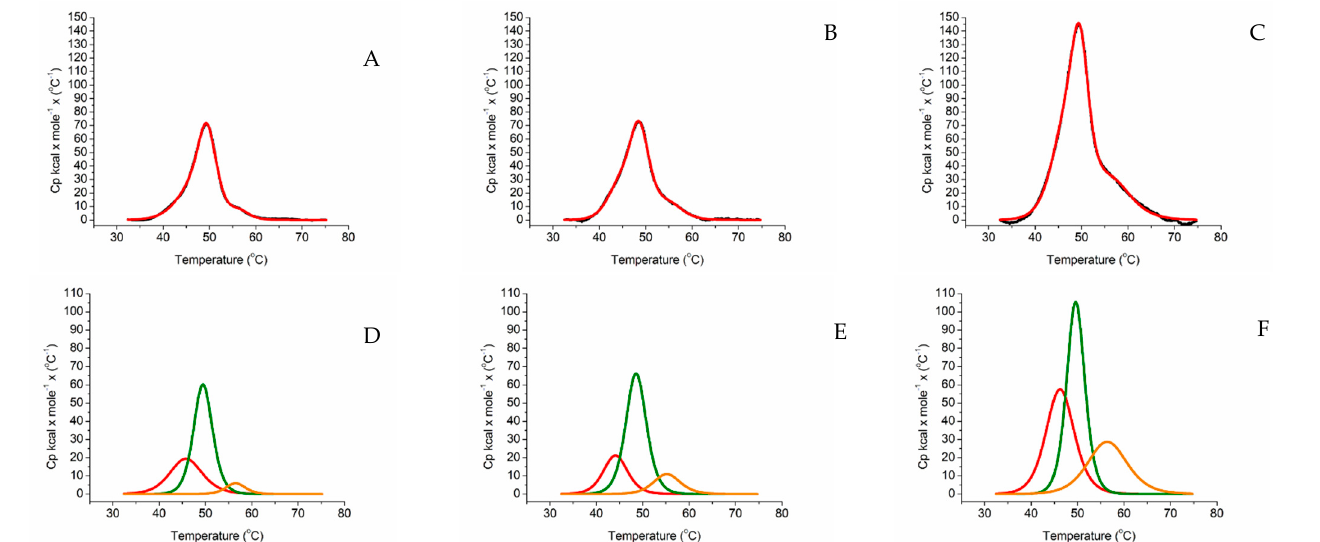
Figure 3. Thermal unfolding measured by DSC of ARO ‐ BMR chimeras. Thermograms of ( A ) ARO ‐ BMR, ( B ) ARO ‐ BMR ‐ 3GLY, ( C ) ARO ‐ BMR ‐ 5GLY. All experiments were carried out at a scan/rate of 90 °C/h. The black lines are the experimental curve of the chimeras, the red lines are the result of the fitting applying a non ‐ two ‐ state denaturation model. Deconvolution of ARO ‐ BMR ( D ), ARO ‐ BMR ‐ 3GLY ( E ), ARO ‐ BMR ‐ 5GLY ( F ). The red lines represent the deconvolution of the denaturation curve of aromatase, the green lines represent the deconvolution of the FAD subdomain from BMR, and the orange lines represent the deconvolution of the FMN subdomain from BMR.